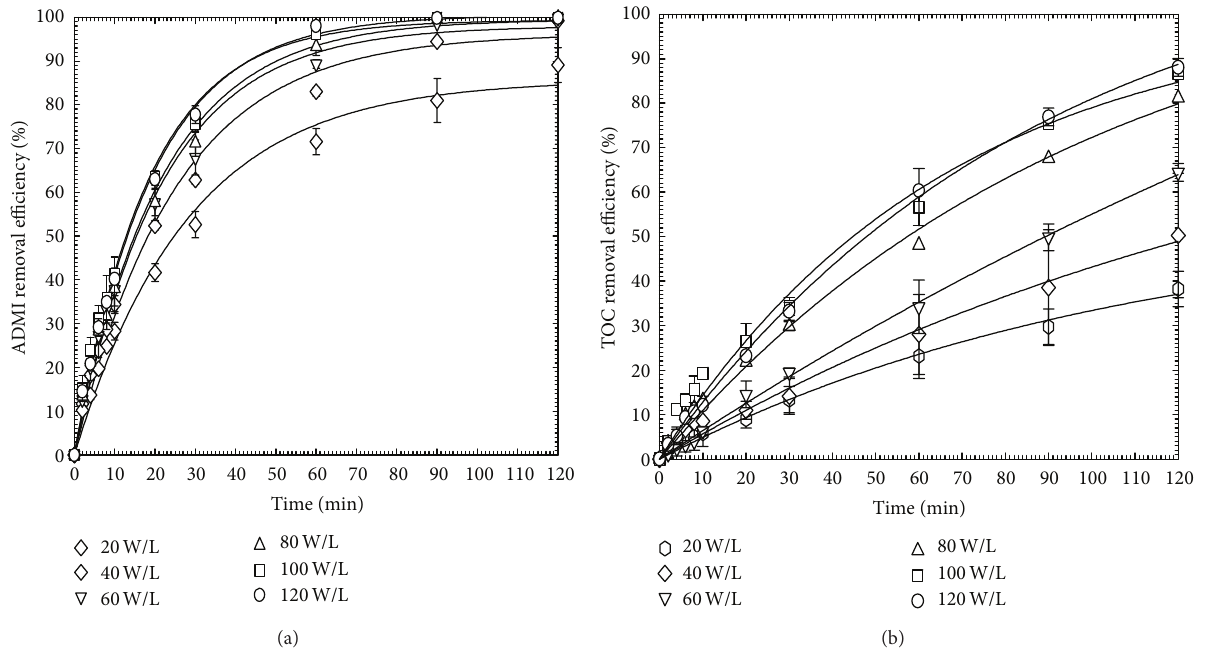
Figure 5: Effect of UV light intensity on OG (a) decolorization and (b) mineralization by UV/ZnO photocatalytic system. The conditions were initial dye concentration of 50mgL −1 , ZnO-coated amounts of 60 gm −2 , and UV light intensity of 20 to 120WL −1 (120WL −1 measured as 2.1mWcm −2 ).